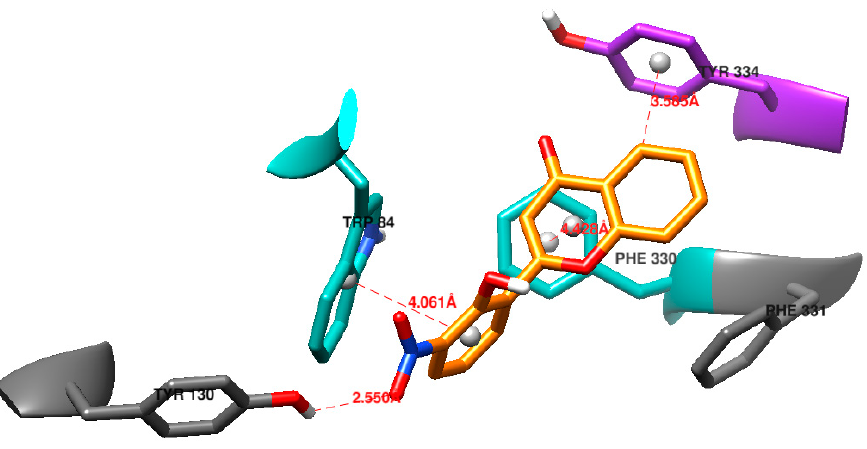
Figure 5. Flavone 3d and its interactions with nearby residues.